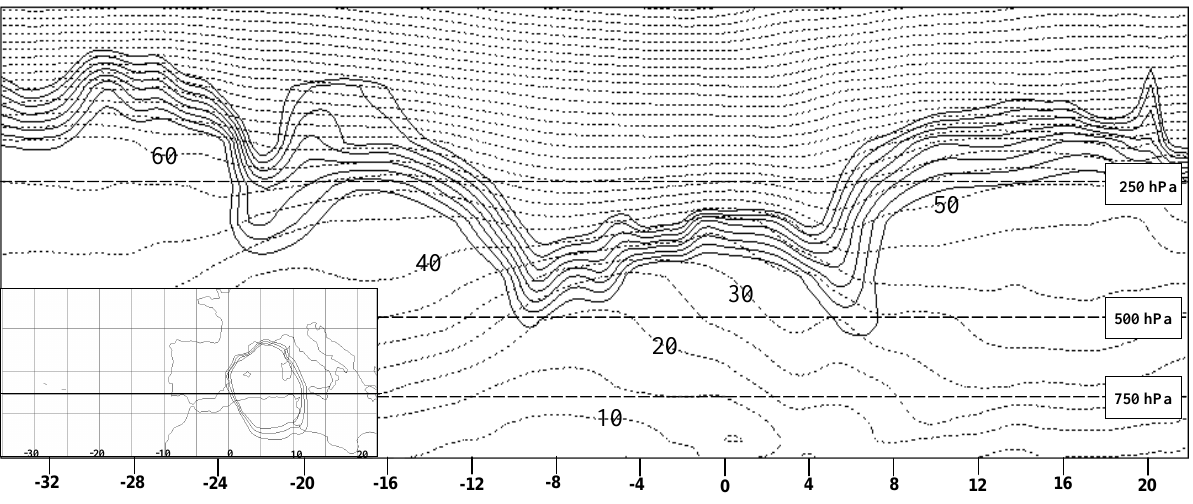
Fig. 13. C21–23 simulated PV (solid lines, PVU) and potential temperature (dashed lines, ◦ C) vertical section across the cyclone at 18:00UTC, 21December. PV isolines from 1.5PVU to 5PVU with a 0.5PVU interval. Potential temperature isolines depicted with a 5 ◦ C interval. Left bottom map shows the vertical section position relative to the cyclone.